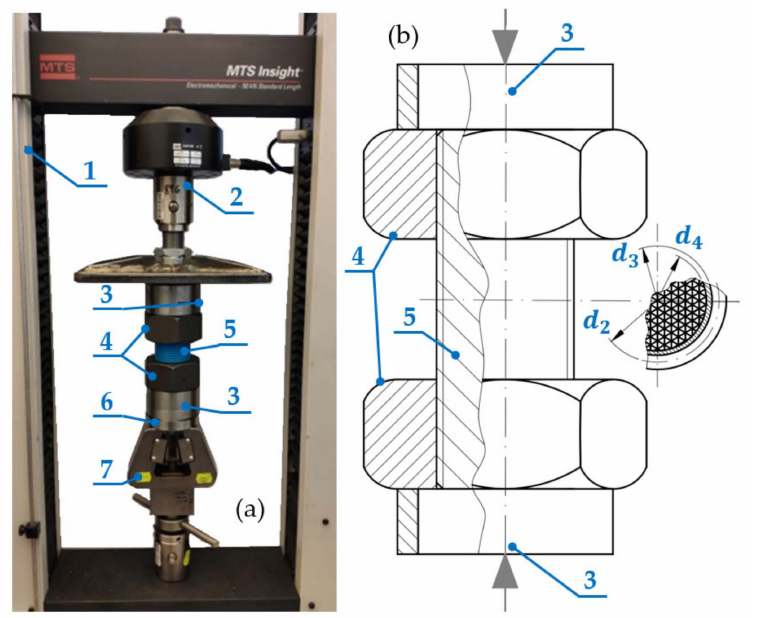
Figure 2. The test setup; ( a ) view, ( b ) scheme; 1—MTS testing machine, 2—load cell, 3—cylinder, 4—nut, 5—threaded rod, 6—aligning element, 7—clamping jaw.